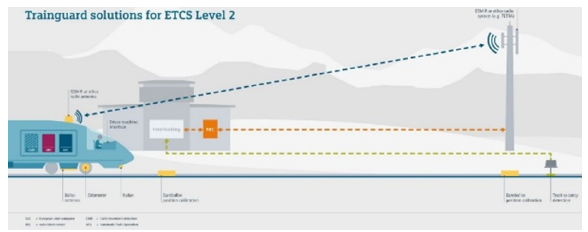
Figure 8. Function of ETCS at level 2 [ mobility. siemens.com